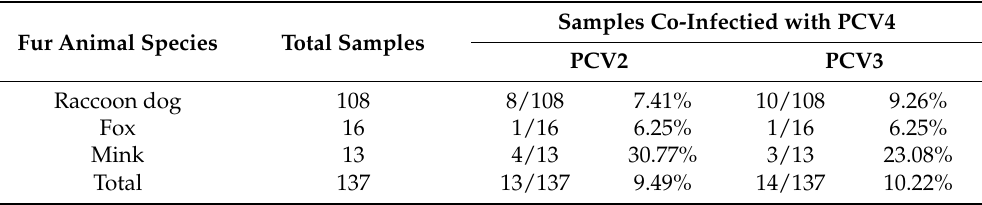
Samples Co-Infectied with